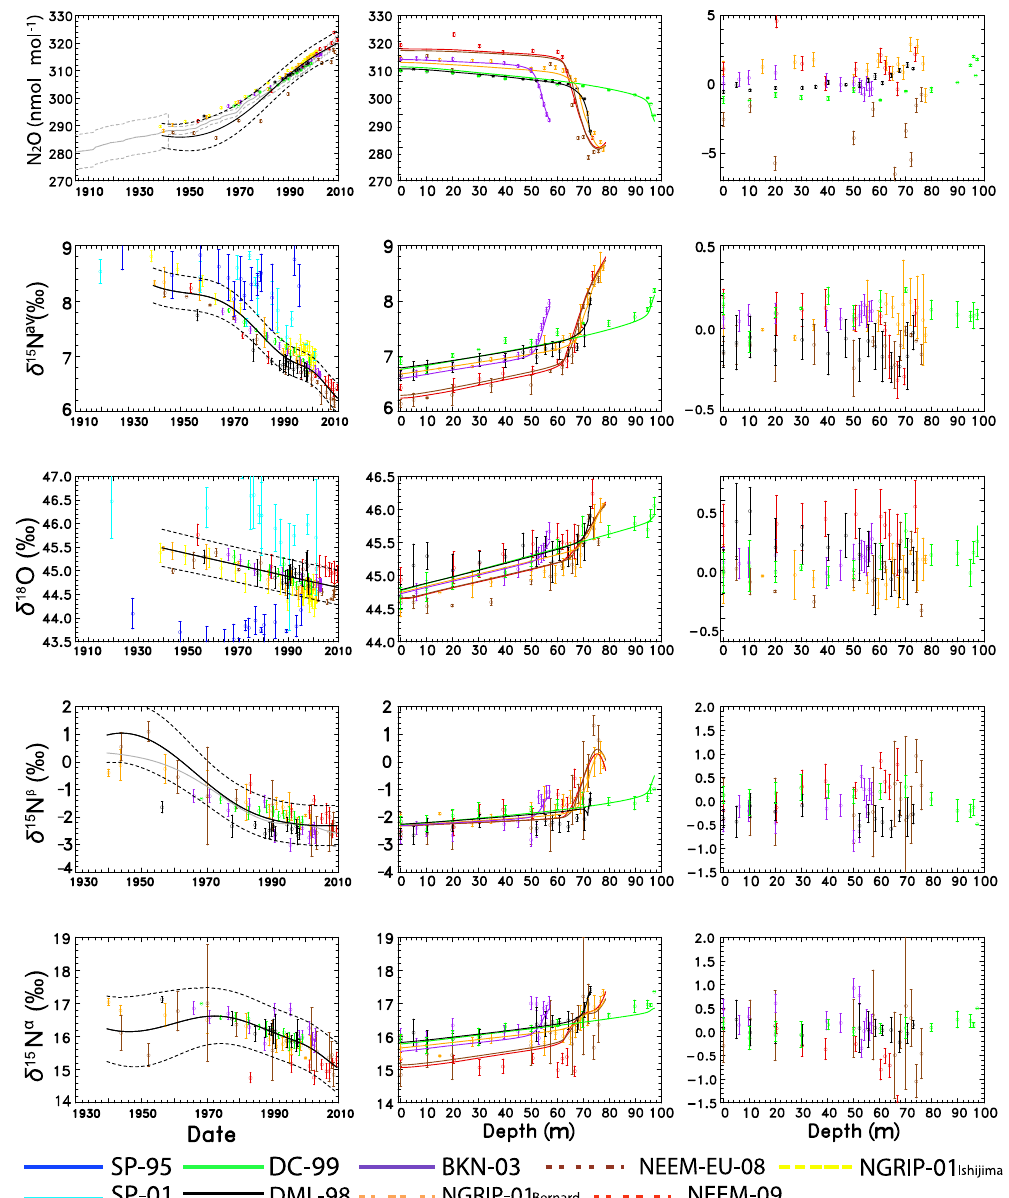
Figure C1. Results of the firn data evaluation (similar to Fig. 2) using the data without re-scaling as indicated in the text. Orange: NGRIP- 01 Bernard ; yellow: NGRIP-01 Ishijima ; brown: NEEM-EU-08; red: NEEM-09; purple: BKN-03; black: DML-98; green: DC-99; blue: SP-95; and light blue: